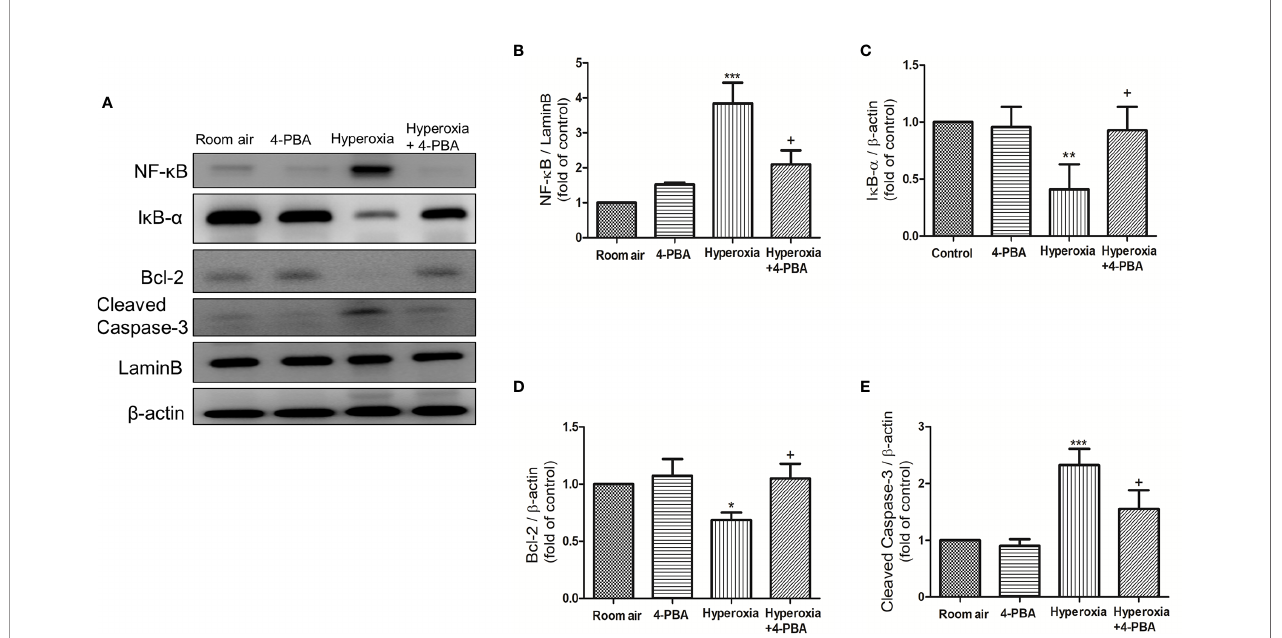
FIGURE 4 | 4-PBA suppresses NF- k B signaling pathway and apoptosis in mice with HALI. (A) Western blot analysis of NF- k B, I k B- a , Bcl-2 and cleaved caspase-3 expression in lung tissues. Relative expressions of NF- k B (B) , I k B- a (C) , Bcl-2 (D) , and cleaved caspase-3 (E) in lung tissues were shown. Data are expressed as